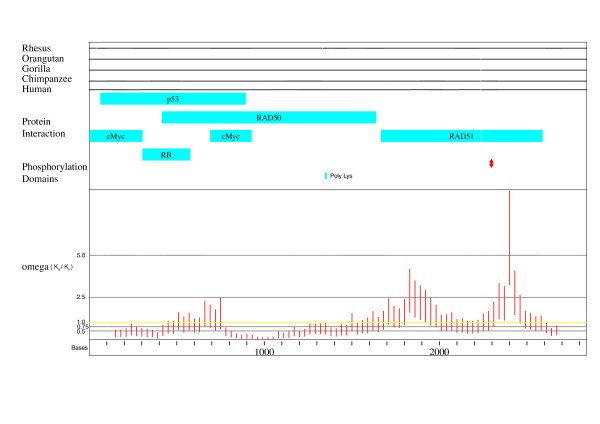
Footprinting the Ka/Ks ratio in primate BRCA1. A DNA alignment of five partial primate sequences from exon 11 of BRCA1 footprinted for adaptive evolution. A codon model of evolution with a model parameter for replacement changes[25] was "footprinted" in 300 base (100 codon) windows and 30 base steps. Red lines indicate the 95% confidence interval for the omega replacement parameter that is an estimate of the Ka/Ks ratio. Ka/Ks > 1 is indicative of adaptive evolution. Two regions (around 1850 and 2400 bp) have 95% confidence intervals for omega that do not include 1, suggesting adaptive evolution is occurring within them. Note that although plotted as single lines in the middle of the window range the 300 bp windows overlap and a single region or site can affect the parameter estimate for multiple adjacent windows. Annotations of protein-protein interaction domains (blue boxes) and phosphorylation sites (red diamonds) are derived from Deng[33]. Sequences: Human 961-3798 of NM007294, Chimpanzee 150-2987 of AF019075, Gorilla 150-2987 of AF019076, Orangutan 150-2987 of AF019077 and Rhesus 150-2984 of AF019078. Scale is in bases and refers to gapped alignment positions.